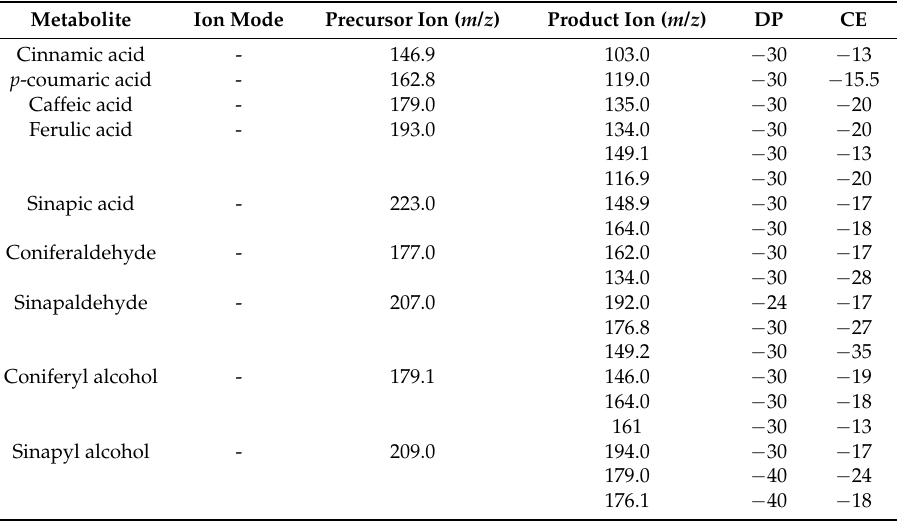
Table 5. MRM detection parameters for intermediate metabolites of lignin